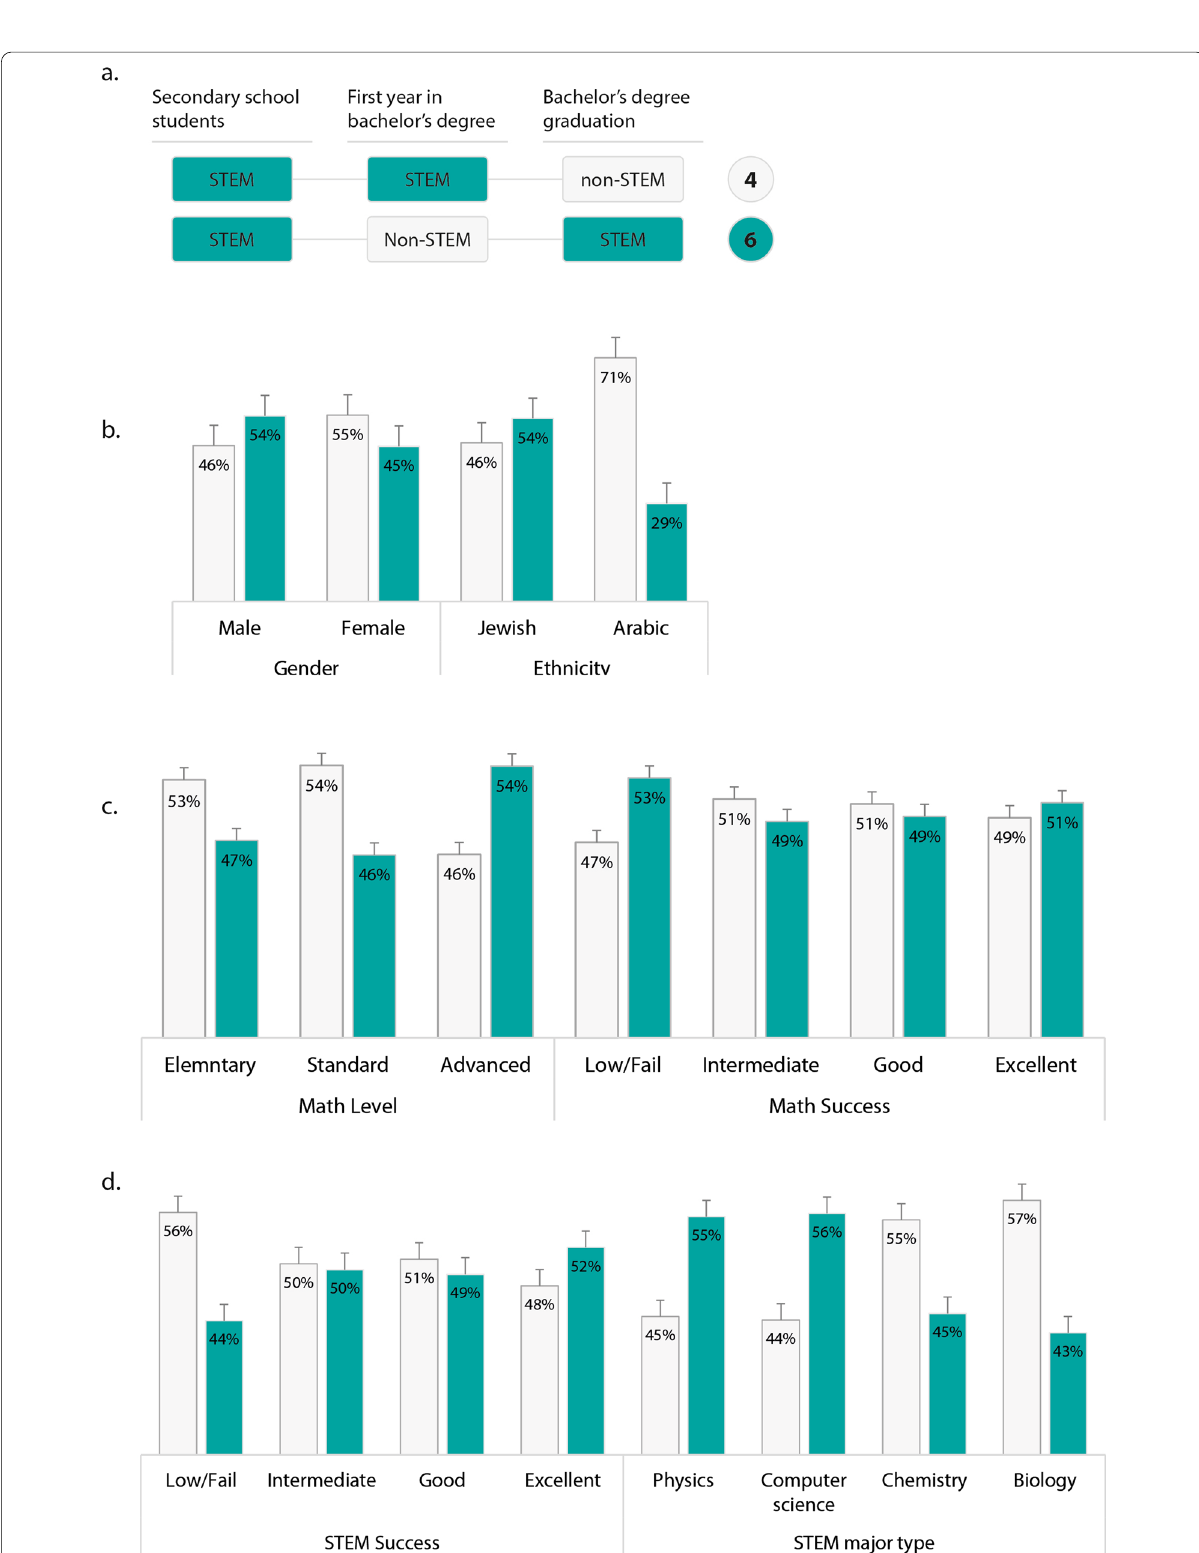
Fig. 8 The characteristics of the pathways begin with secondary STEM major: a illustration of the relevant pathways, #4 and #6; b the distribution of the demographic characteristics between these pathways; c the distribution of the educational characteristics in mathematics between these pathways; d the distribution of the educational characteristics in STEM major between these